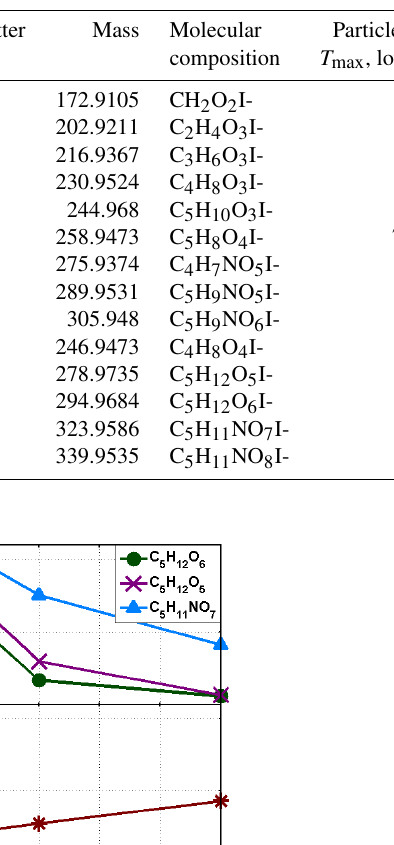
Table 1. Gas- and particle-phase compounds detailed in the mass spectra in Fig. 2 (top). Many molecular compositions are observed in both the gas and particle phases. If the composition is observed in the particle phase, a T max is listed at both low (0ppb input NO) and high (20ppb input NO) NO x . The desorption shape is also listed and is consistent across NO x conditions. The significance of the T max and desorption shape are discussed in detail in the text. If the compound is only detected in the gas phase, “NA” is listed in the T max and thermogram columns, indicating that those values are not applicable.